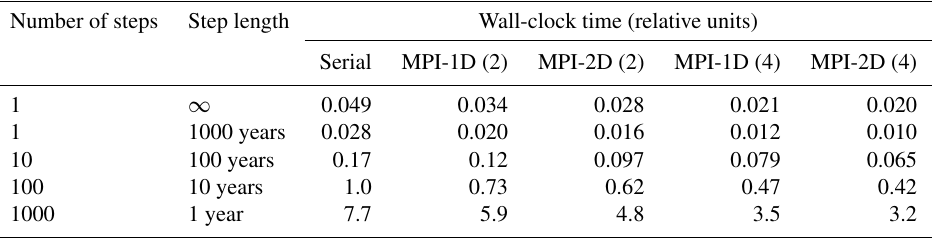
Table 5. Execution times of the COUPSIM best-fit experiment. One unit of CPU time corresponds to 9:14.73min here. The executing platform had an Ubuntu 16.04.6 LTS operating system (64bit kernel 4.4.0-185-generic) running on a 1.90GHz Intel ® Core ® i7-8650U CPU; the codes were compiled with GFortran 5.4.0 using optimisation level -O0 . Experiments carried out with MPI enabled used Open MPI v. 1.10.2 and were run on as many processes as indicated in brackets. Number of steps Step length Wall-clock time (relative units) Serial MPI-1D (2) MPI-2D (2) MPI-1D (4) ∞